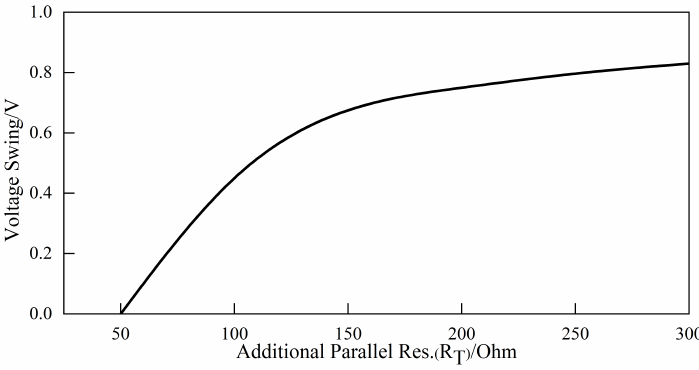
Figure 14. Relation between shunt resistance and voltage